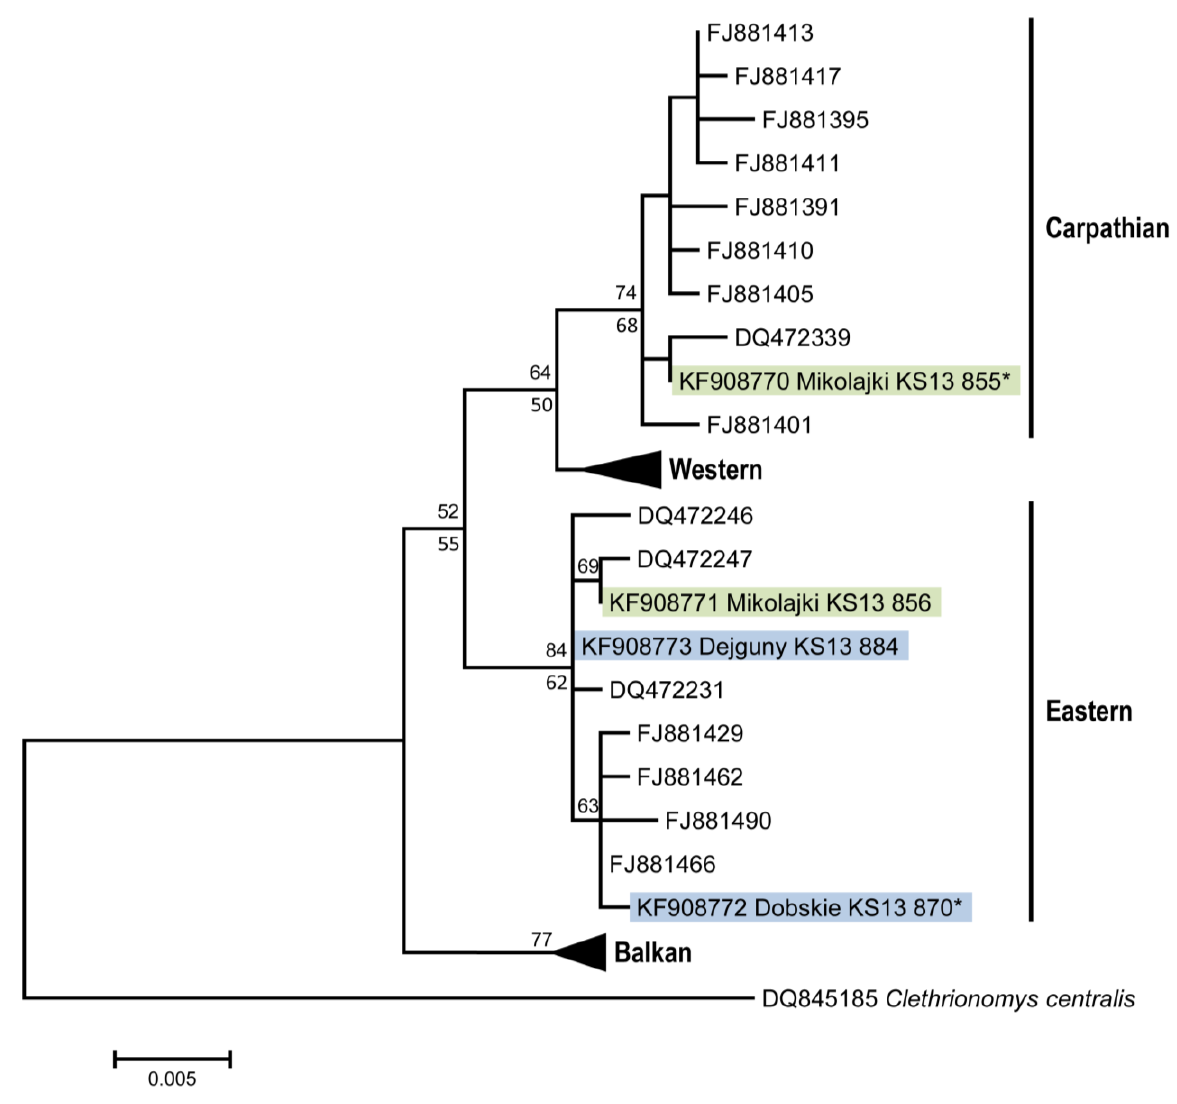
Figure 3. Phylogenetic relationships of cytochrome b sequences (843 nt) in Clethrionomys glareolus from the study region (highlighted) relative to major phylogeographic lineages (Carpathian, Western, Eastern, Balkan; [43]) within the species. Representative sequences from all phylogeographic lineages present in the larger region (see [43]) were obtained from GenBank, and Clethrionomys ( Myodes ) centralis was used as outgroup. Clusters of phylogeographic lineages without novel sequences from Poland in this study were condensed to triangles with sizes proportional to sequence numbers. Support values for Neighbor-Joining or Bayesian phylogenetic algorithms exceeding 50 percent are reported above/below main branches. * Identical sequences: KS13/855 = KS13/861; KS13/870 =